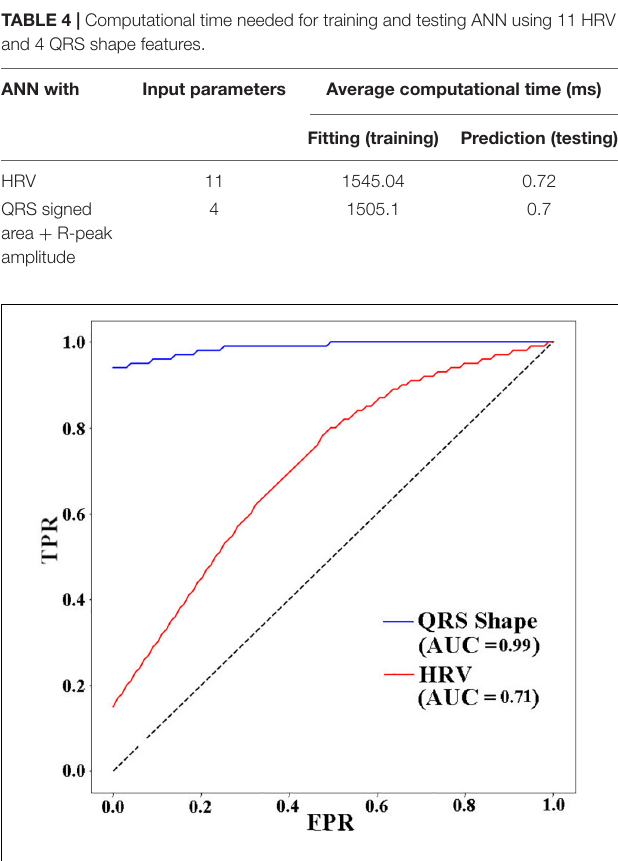
FIGURE 5 | ROC AUCs (receiver operating characteristic area under curves) of ANNs for different input features used to predict VF 30 s before the occurrence. TPR: true positive rate, FPR: false positive